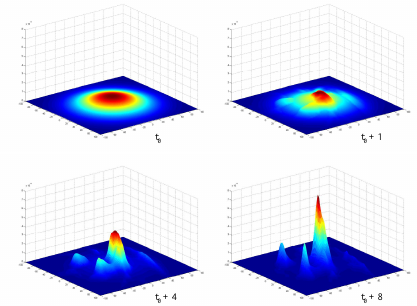
Figure 5: Evolution of the PMF probability density function. The capability of the filter to maintain the full probability distribution over the grid space can be observed.